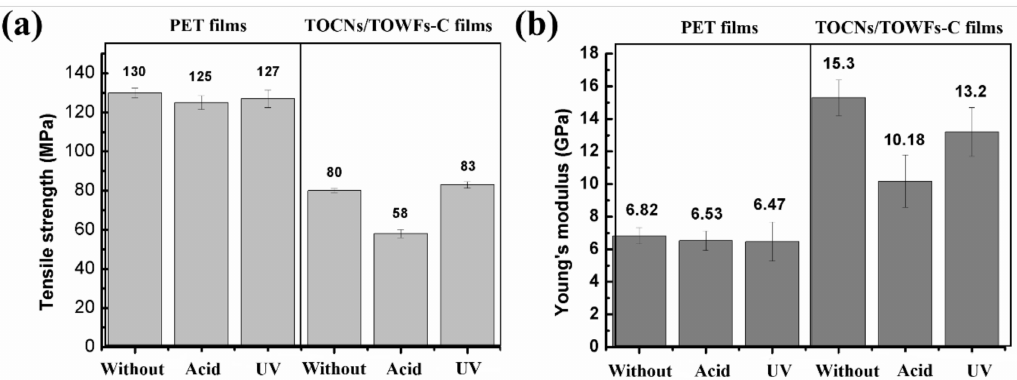
Figure 7. Mechanical properties of the TOCNs/TOWFs-C films and PET films without treatment, with acid or UV radiation treatment, (a) Tensile strength, (b) Young’s